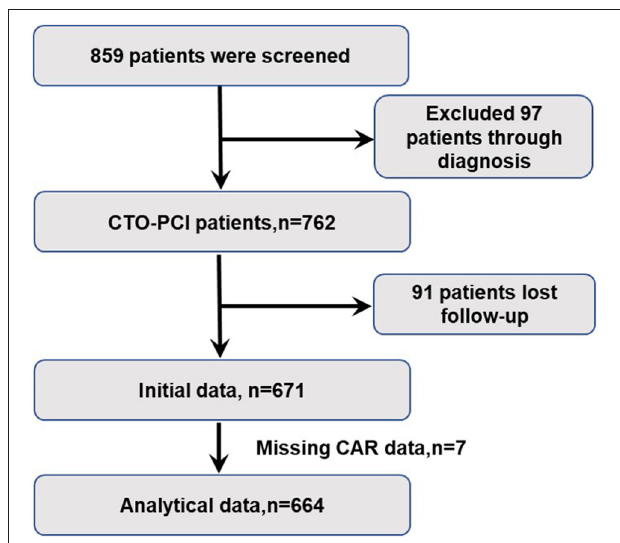
FIGURE 1 | Study design. CTO, chronic total occlusion; PCI, percutaneous coronary intervention.